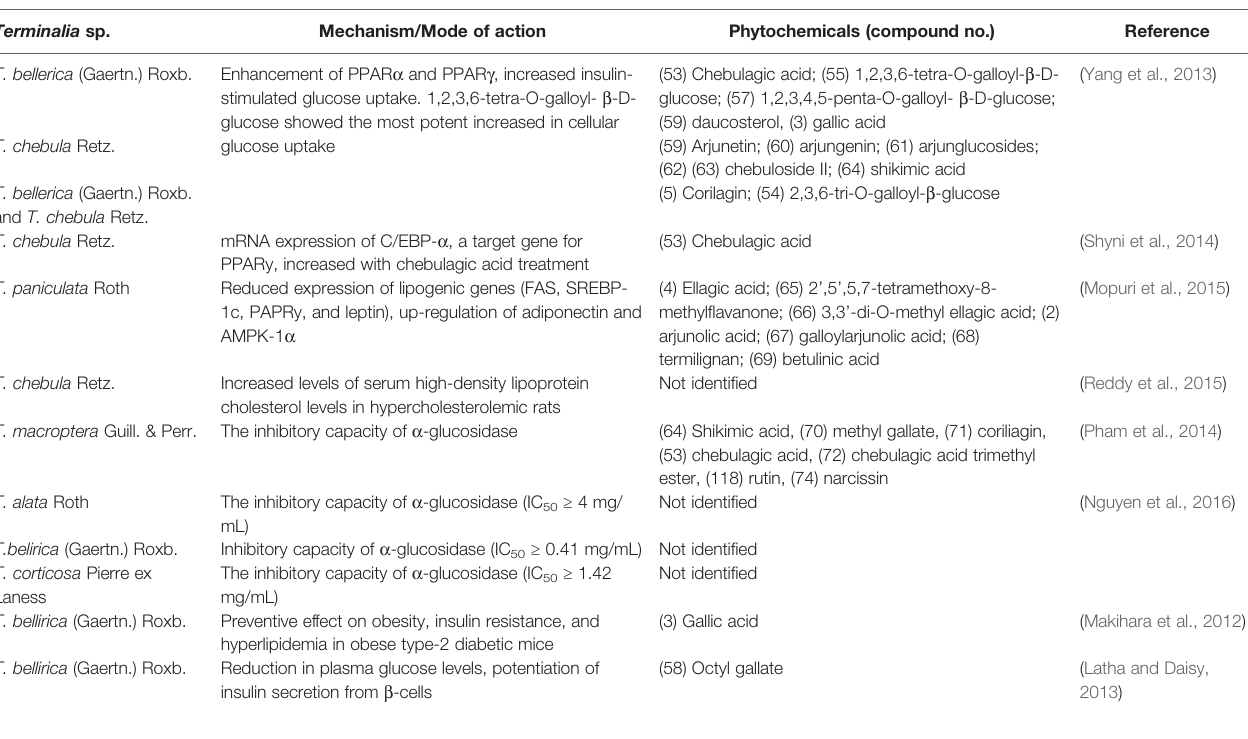
TABLE 3 | Summarization of the antiobesity and antidiabetic studies of different Terminalia species. Terminalia